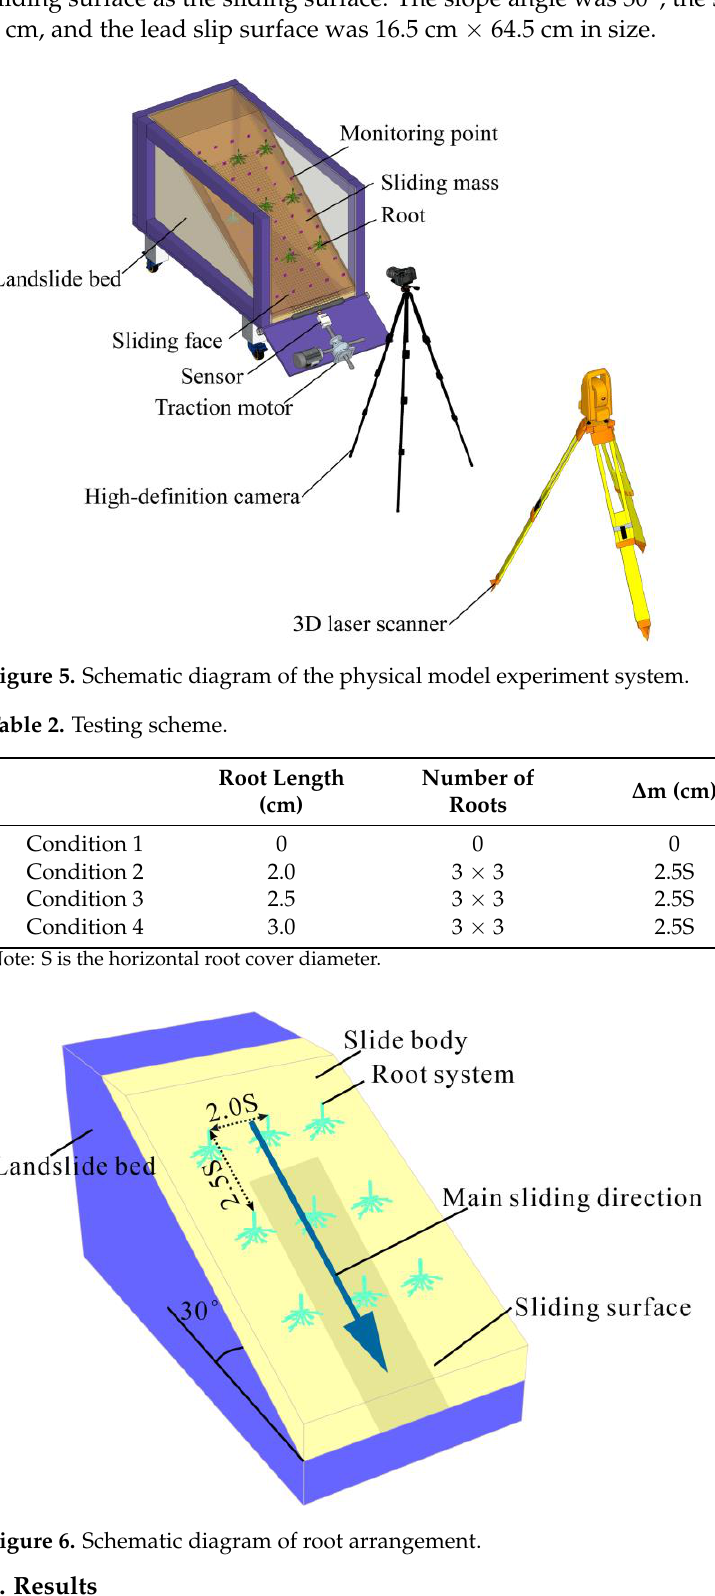
Figure 6. Schematic diagram of root arrangement.